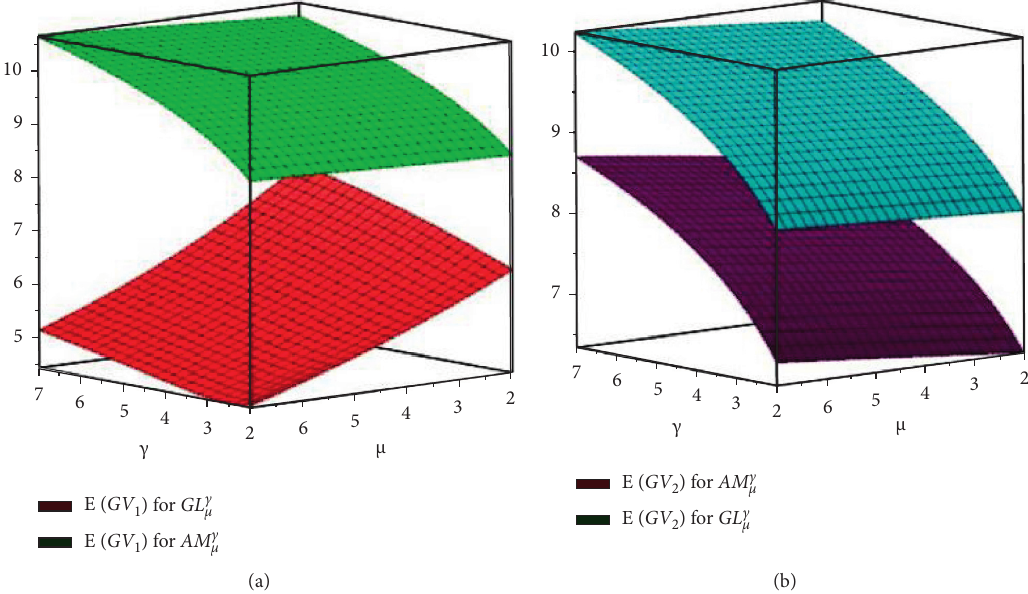
c μ and AM μ and (b) the second Gourava entropies for GL